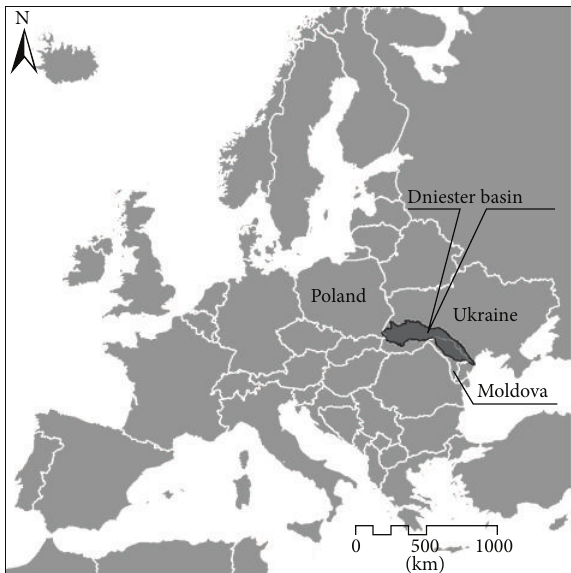
Figure 1: Location of the Dniester river basin in Europe.